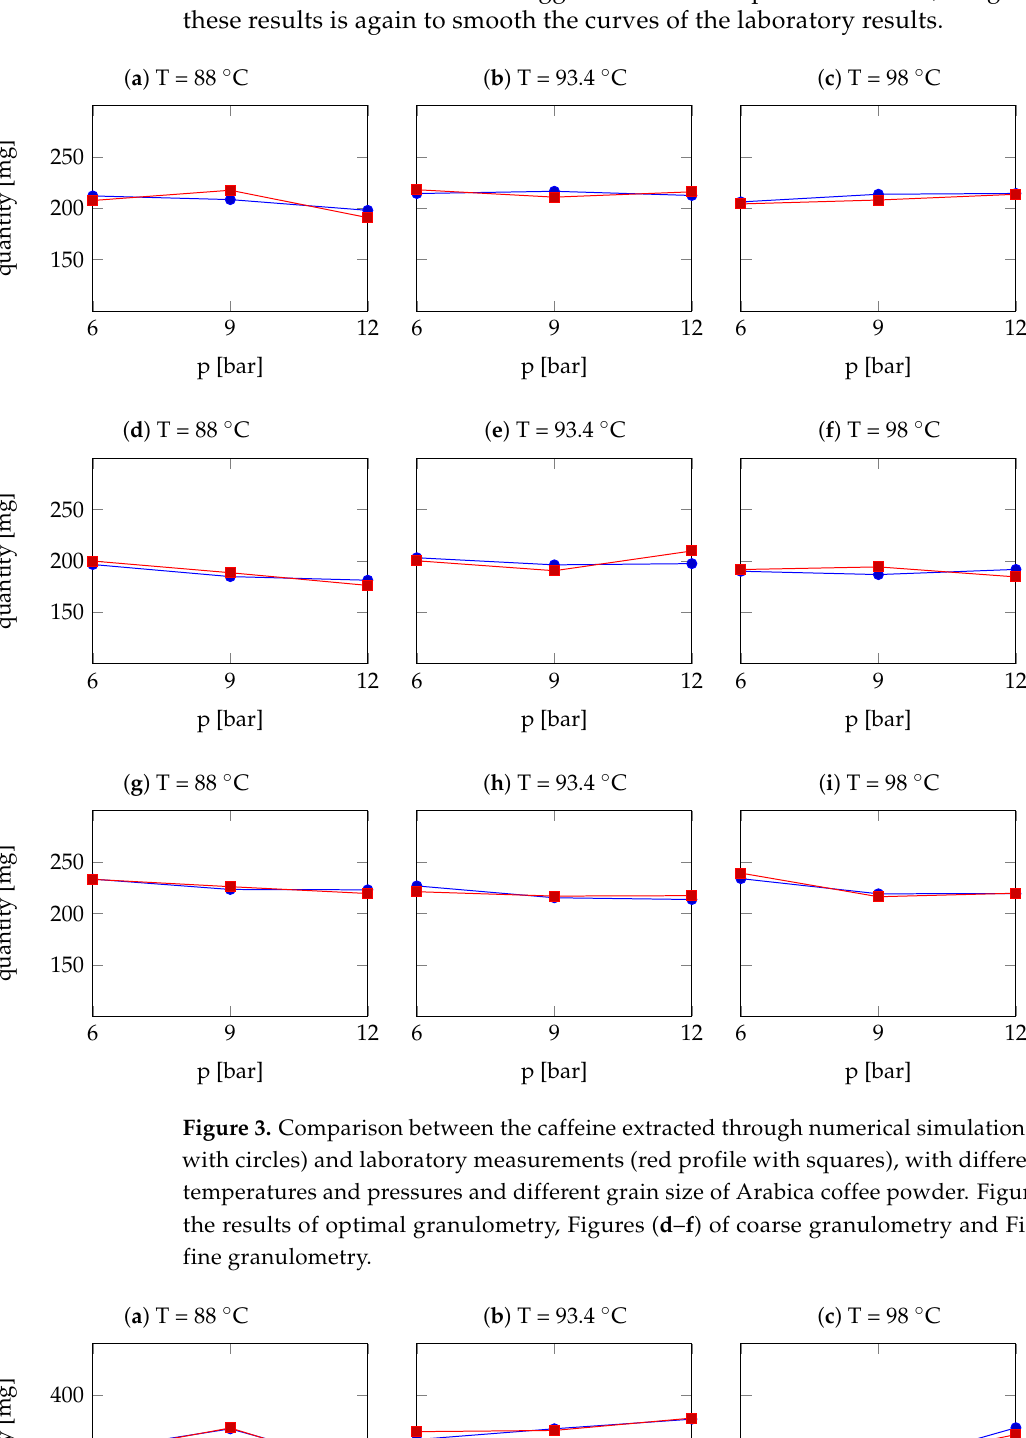
model of the reactive terms struggles to follow the peaks. However, the general trend of these results is again to smooth the curves of the laboratory results.